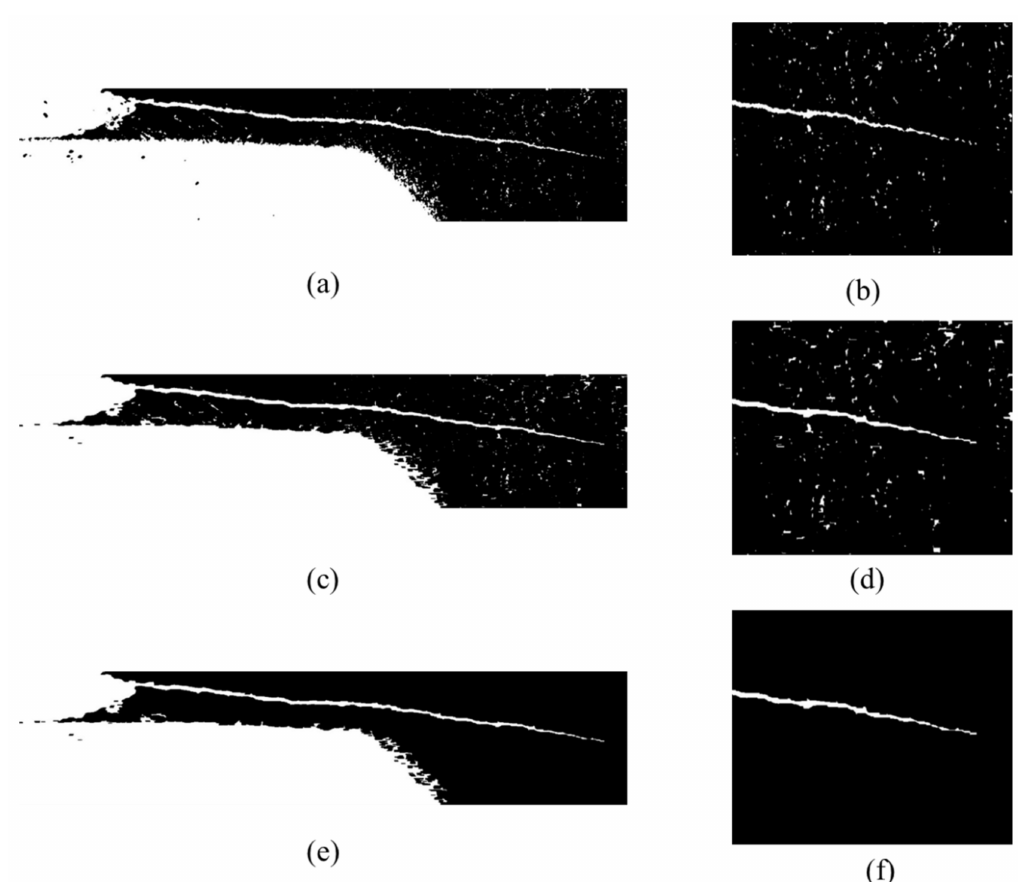
Figure 16. Results after morphological operation and small area removal: ( a ) crack region after threshold segmentation; ( b ) crack tip after threshold segmentation; ( c ) crack region after morphological operation; ( d ) crack tip after morphological operation; ( e ) crack region after small area removal; ( f ) crack tip after small area removal.